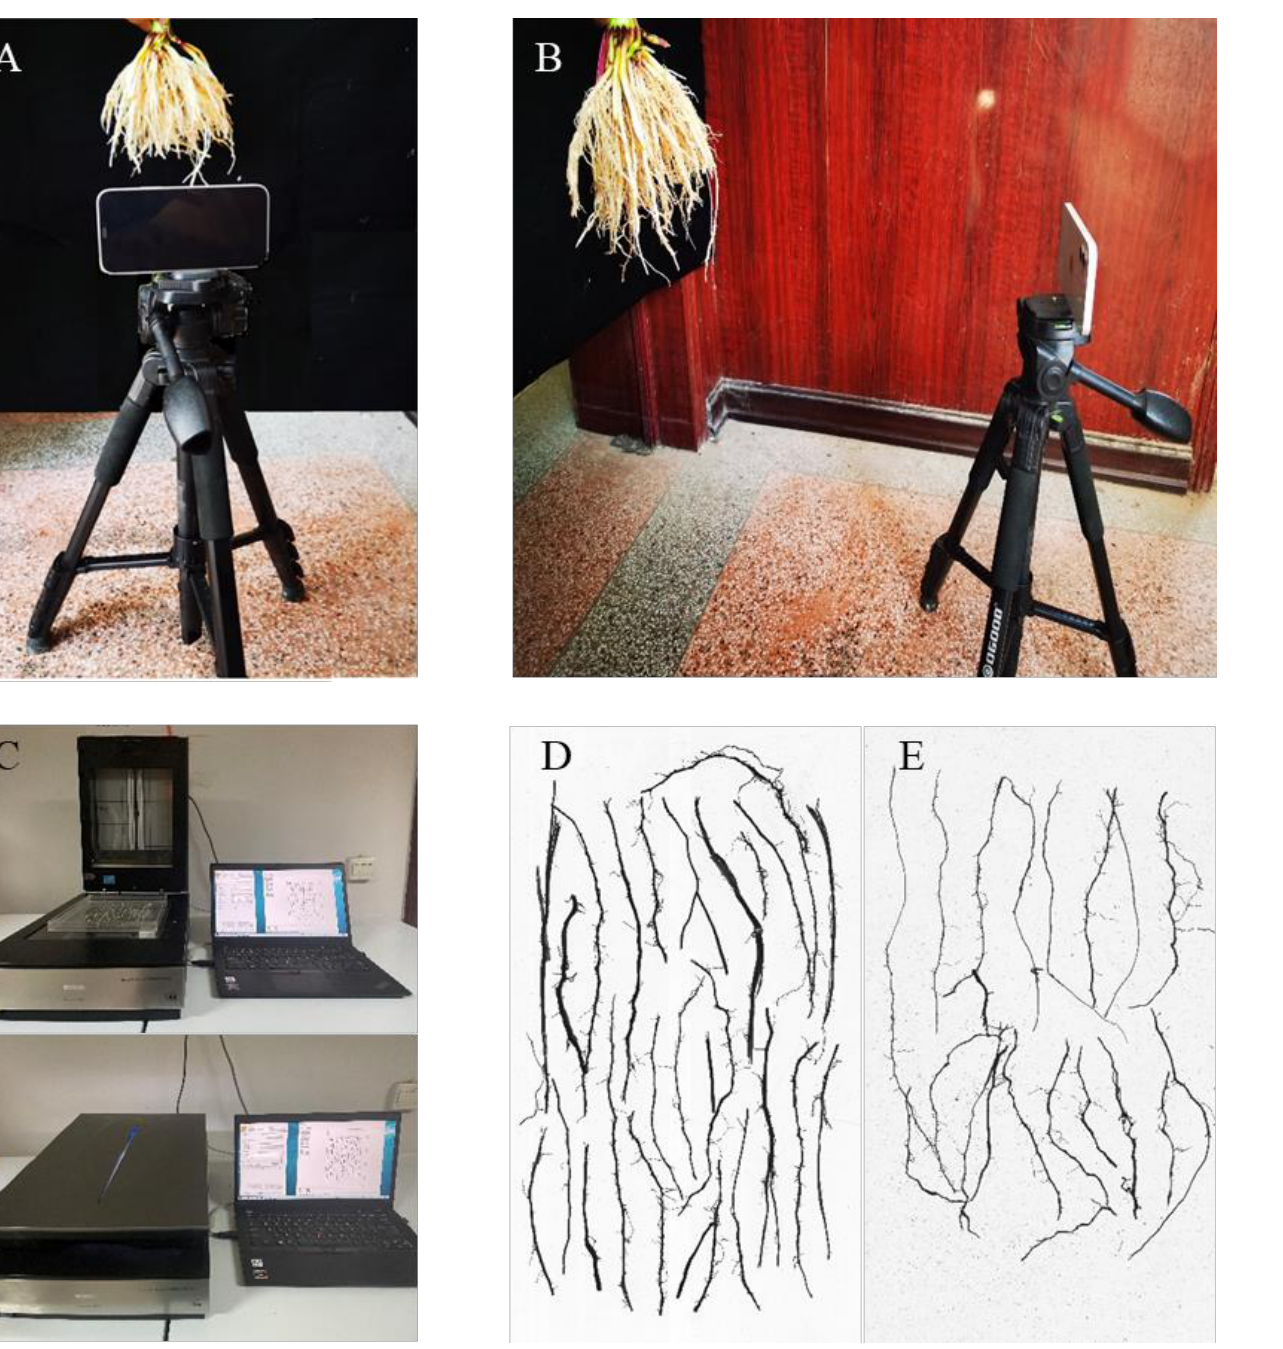
Figure 4. The whole picture of maize root system and root system scan pictures. ( A , B ) was the shooting method of the main maize root system. The maize roots of different treatments were fixed on the black background cloth, and the camera was fixed on the tripod 50 cm away from the roots system for shooting; ( C ) is the instrument for root scanning; ( D , E ) was a partial image of a clean root scanned and it selected from thou-sands of images. All the treatments roots were scanned in this way. Table 2. Root traits and their functional characteristics.